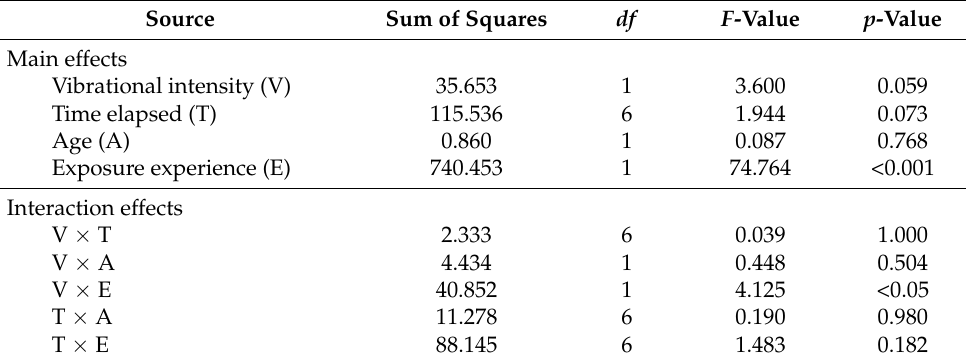
Table 7. ANOVA results of VPTW at a VPT test frequency of 125